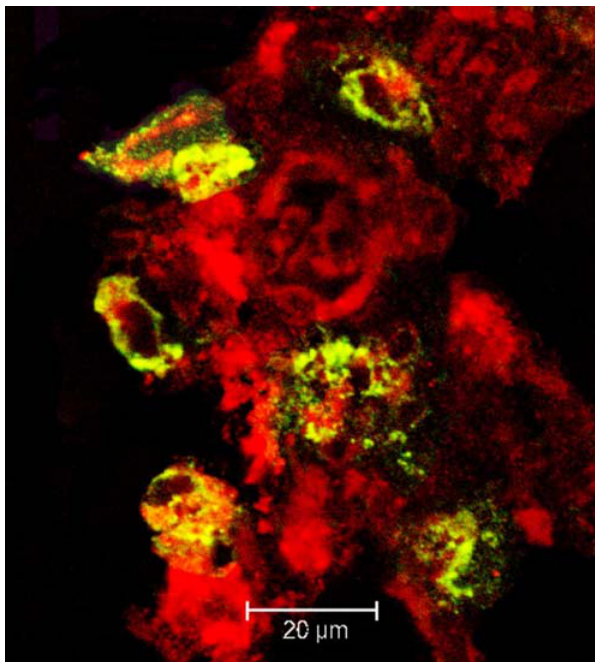
Figure 4. Macrophages were also identified as CCL4 + cells. Macrophages (CD68 + ) are red, CCL4 + cells are green, overlap of red and green fluorescence is seen as yellow.